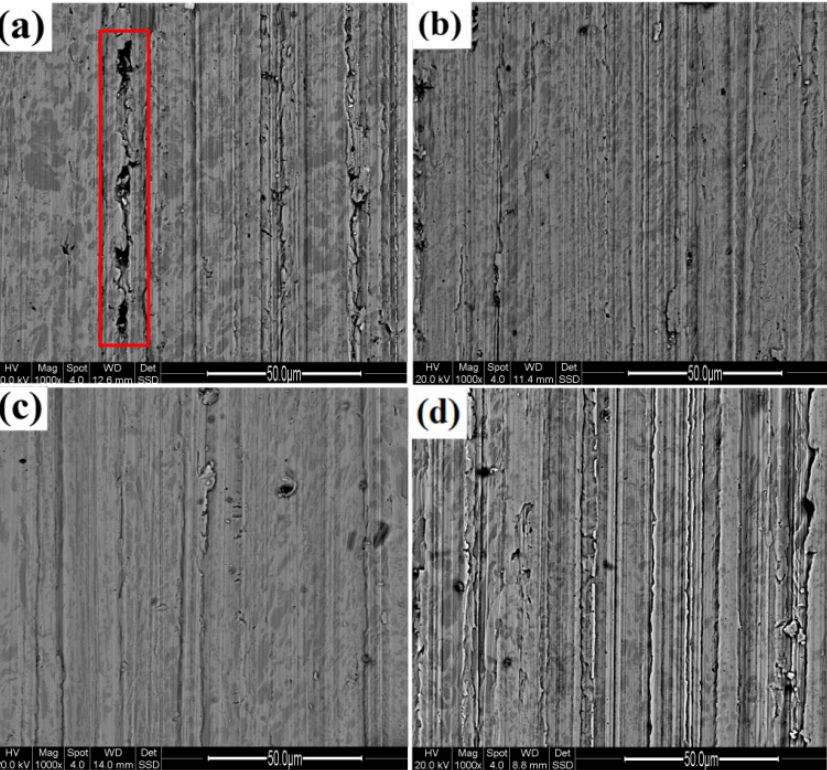
Figure 16. Morphology of the wear surface of HCCI hardfacing layer with different V contents, ( a ) 0 V, ( b ) 0.83 V, ( c ) 1.50 V, ( d ) 2.32 V.